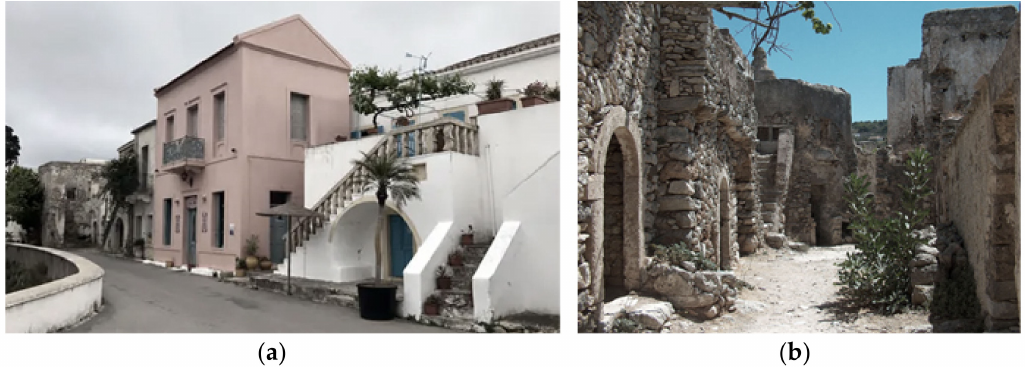
Figure 20. Mylopotamos ( a ) and Kato Chora ( b ) in Kythera.